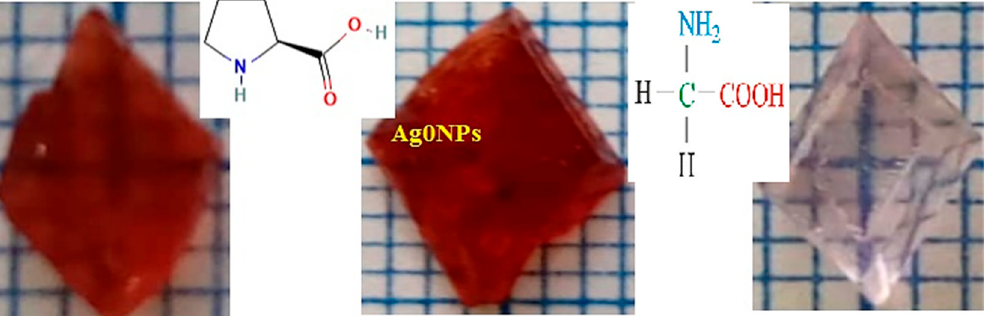
Figure 1. Visual inspection of cobalt chloride doped crystals: proline, proline-Ag 0 NPs and glycine, respectively.